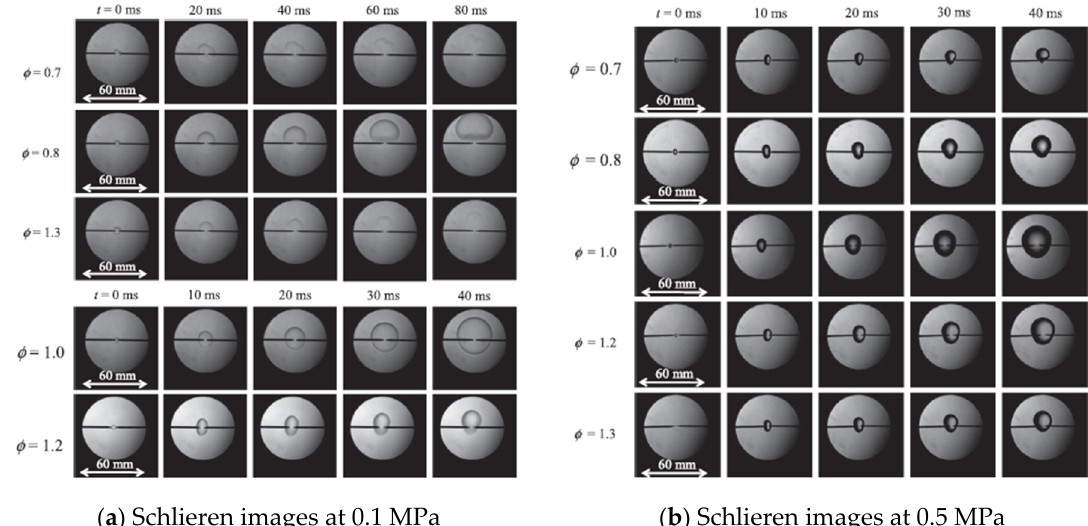
Figure 6. Schlieren images of NH 3 -air premixed flames: ( a ) P i = 0.1 MPa; ( b ) P i = 0.5 MPa. Courtesy of Elsevier [60].